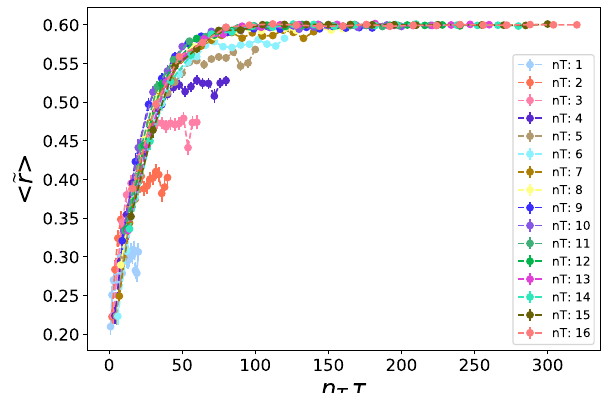
τ past the insertion of T gates, r 〉 plotted as a function of n (cid:101) T ≈ 0.39 and ≈ 0.6. The plateau for smaller n r r (cid:101) (cid:101) Poisson GUE